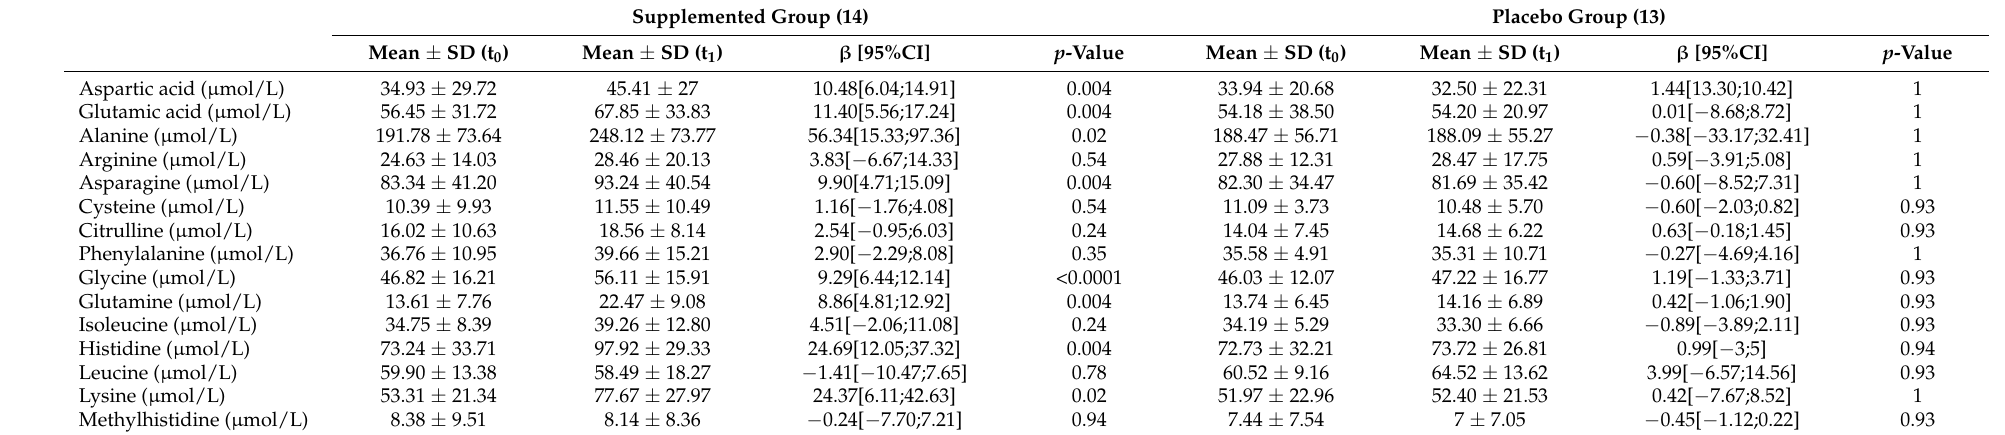
Table 4. Within-group differences for the 22 plasma amino acids and metabolites in the supplemented and placebo groups. The estimate of the effect β , its 95% confidence interval (CI), and the adjusted p -value of the null hypothesis of a null effect are